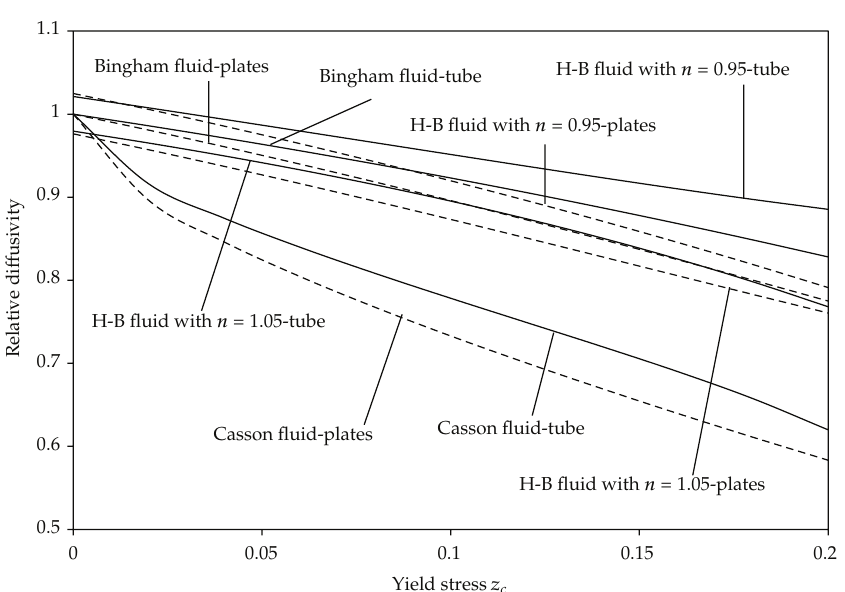
Figure 3: Variation of the relative di ff usivity with yield stress for some non-Newtonian fluids when they flow in a tube and between parallel flat plates.